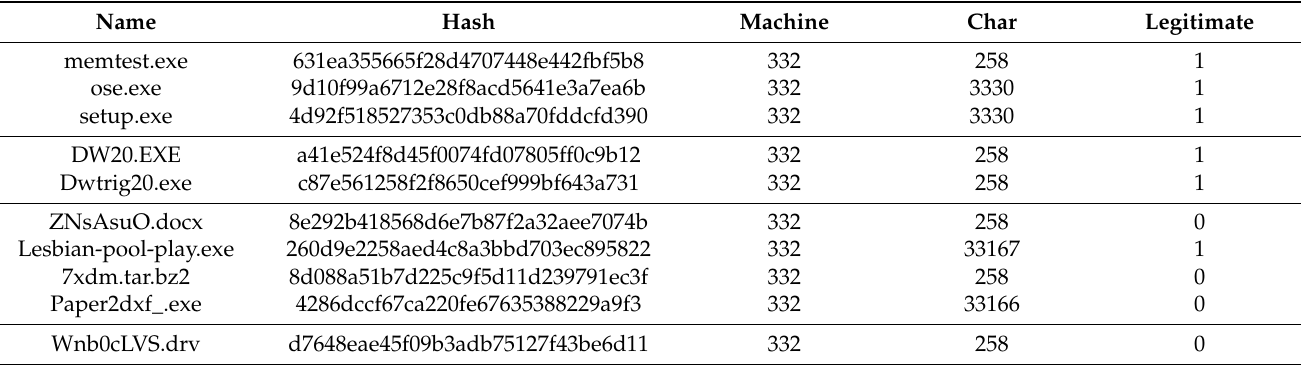
Table 3. Part of contradictory data (before